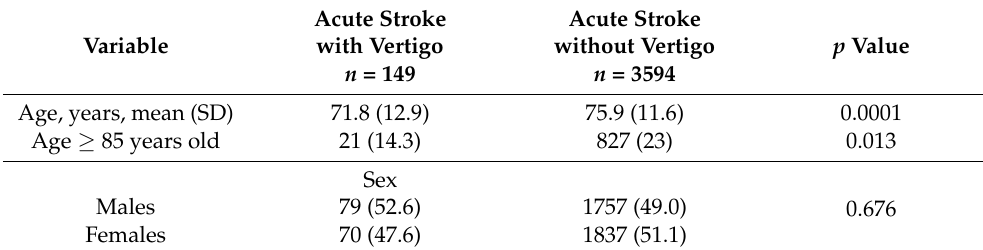
Table 1. Demographics, data in acute stroke patients with vertigo versus